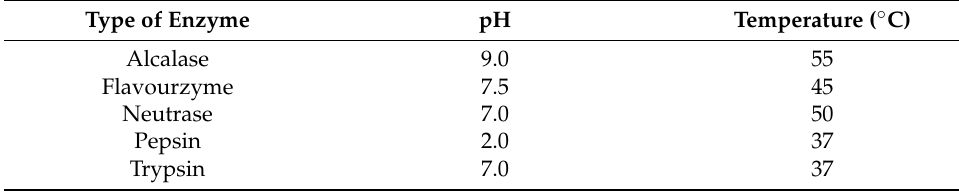
Table 1. Optimal enzymatic conditions for different